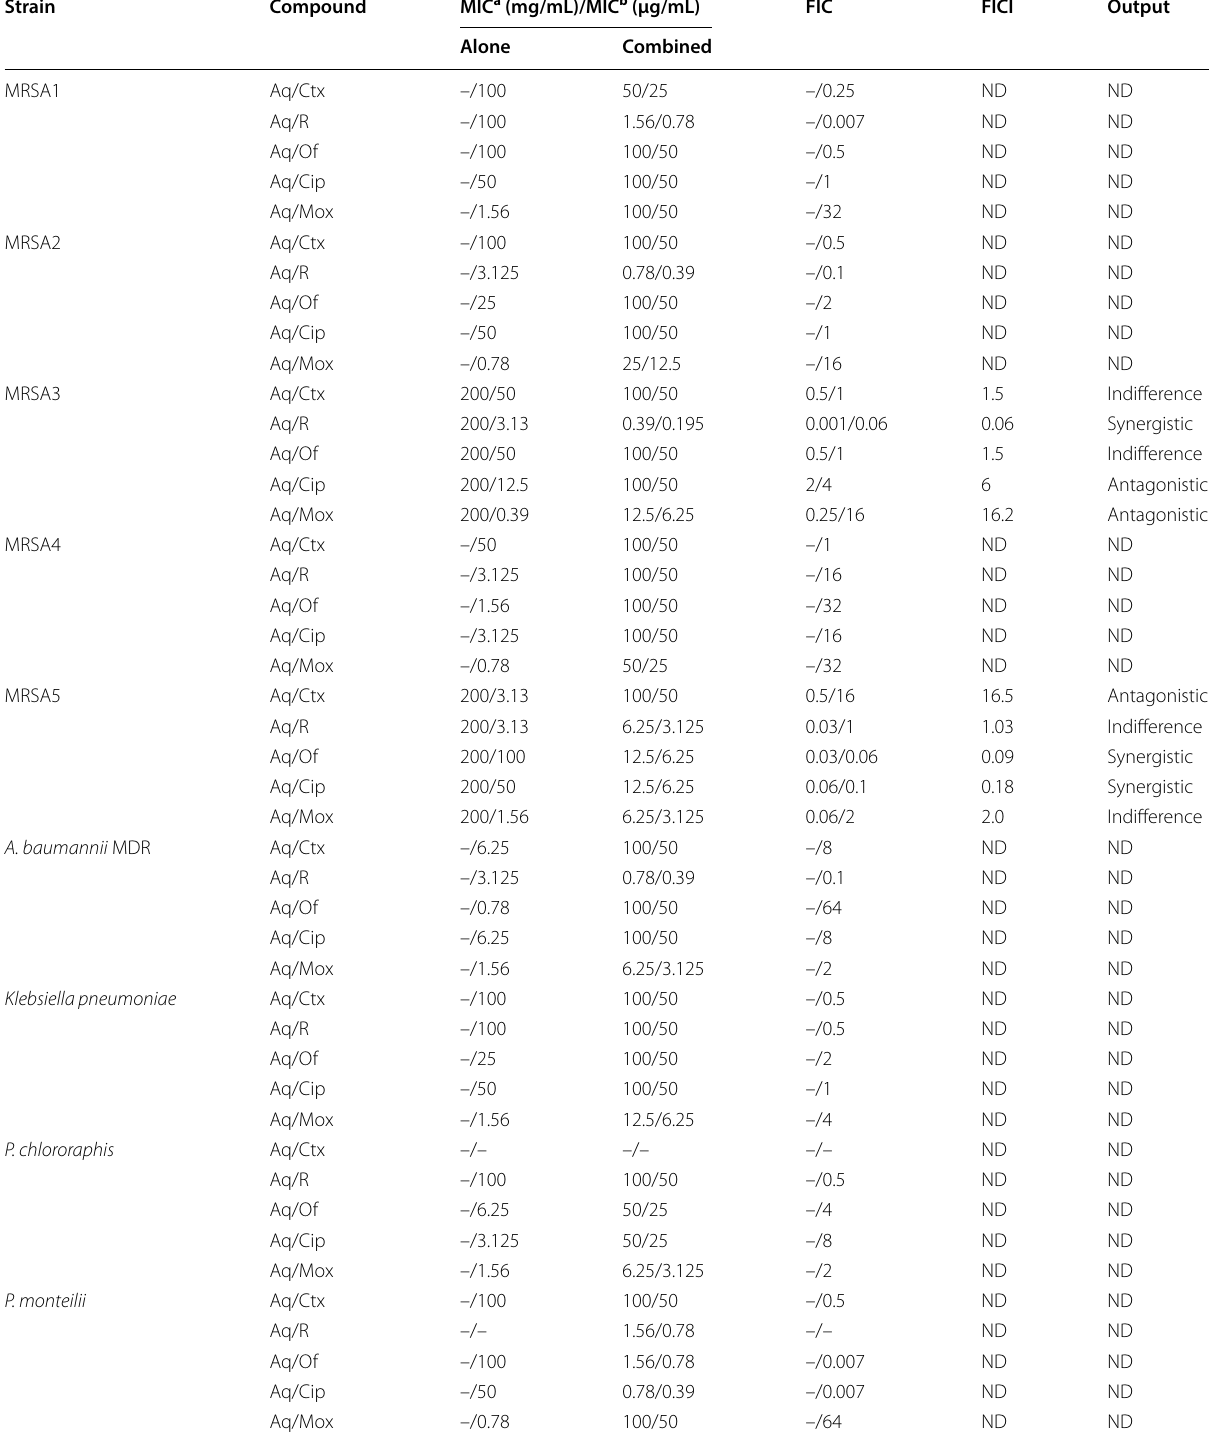
Table 7 Minimum inhibitory concentration (MIC) and fractional inhibitory concentration (FIC) of aqueous extract, each antibiotic alone and their combination against MDR pathogenic bacterial